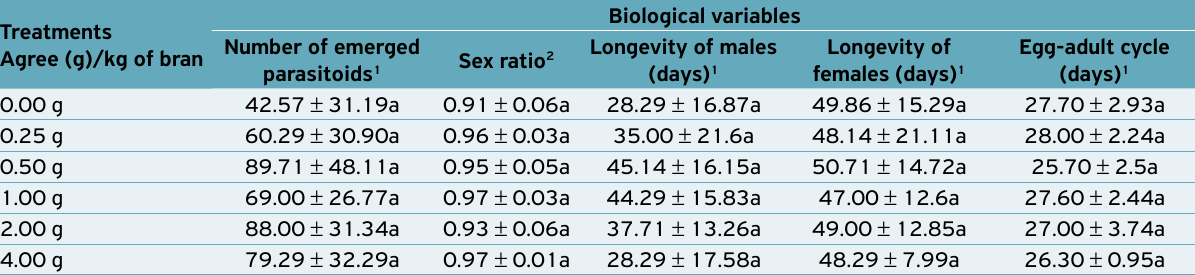
Table 2. Mean ± standard deviation of number of emerged parasitoids, sex ratio, male longevity, female longevity and egg-adult cycle of Palmistichus elaeisis offspring (Hymenoptera: Eulophidae) in Tenebrio molitor (Coleoptera: Tenebrionidae) pupae treated with Bacillus thuringiensis (23 to 27 ºC, 60 to 80% RH and 12-hour photoperiod)